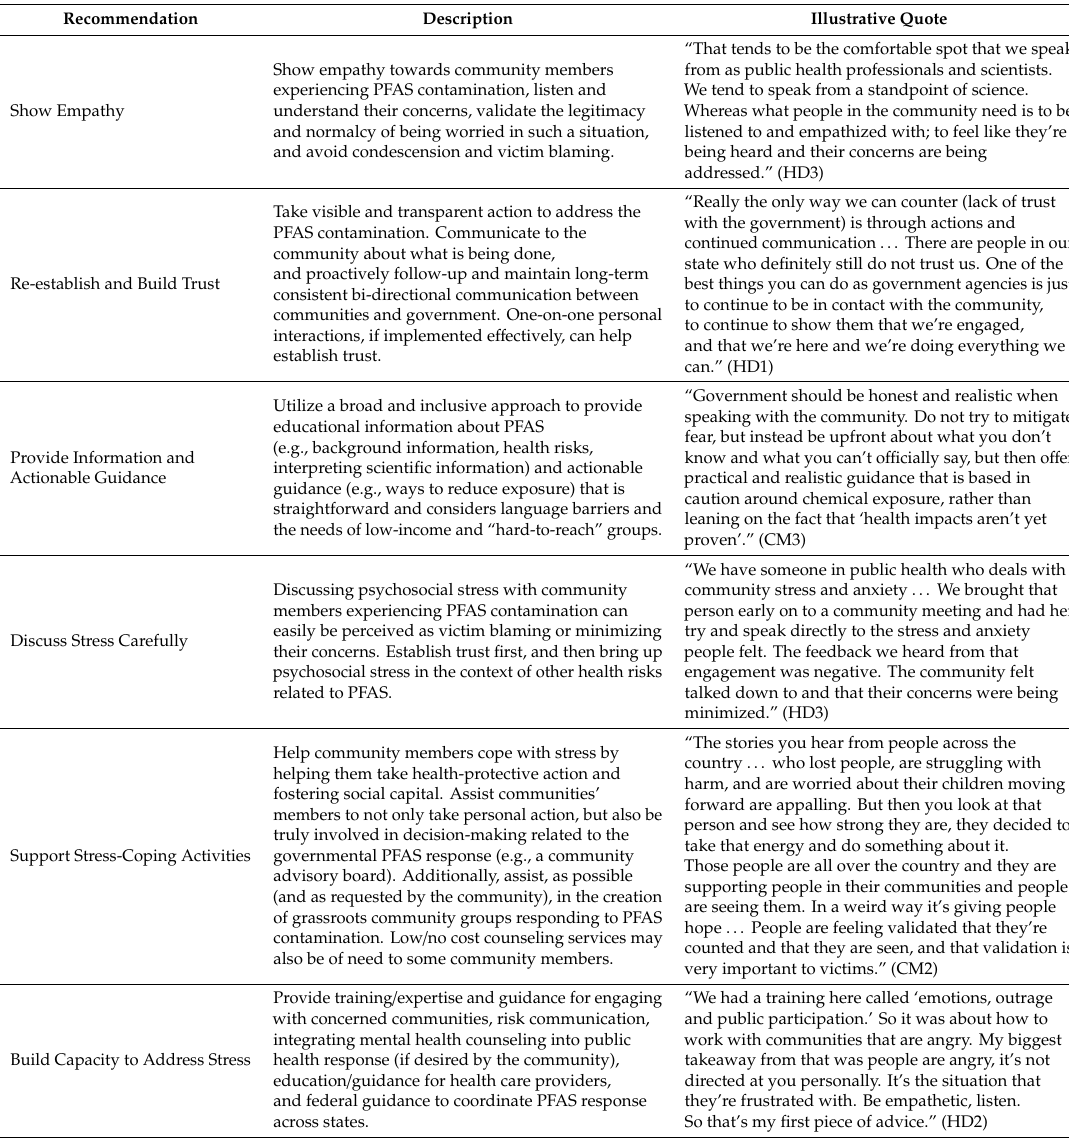
Table 2. Interviewee recommendations for public health and other government agencies on addressing psychosocial stress in communities impacted by PFAS